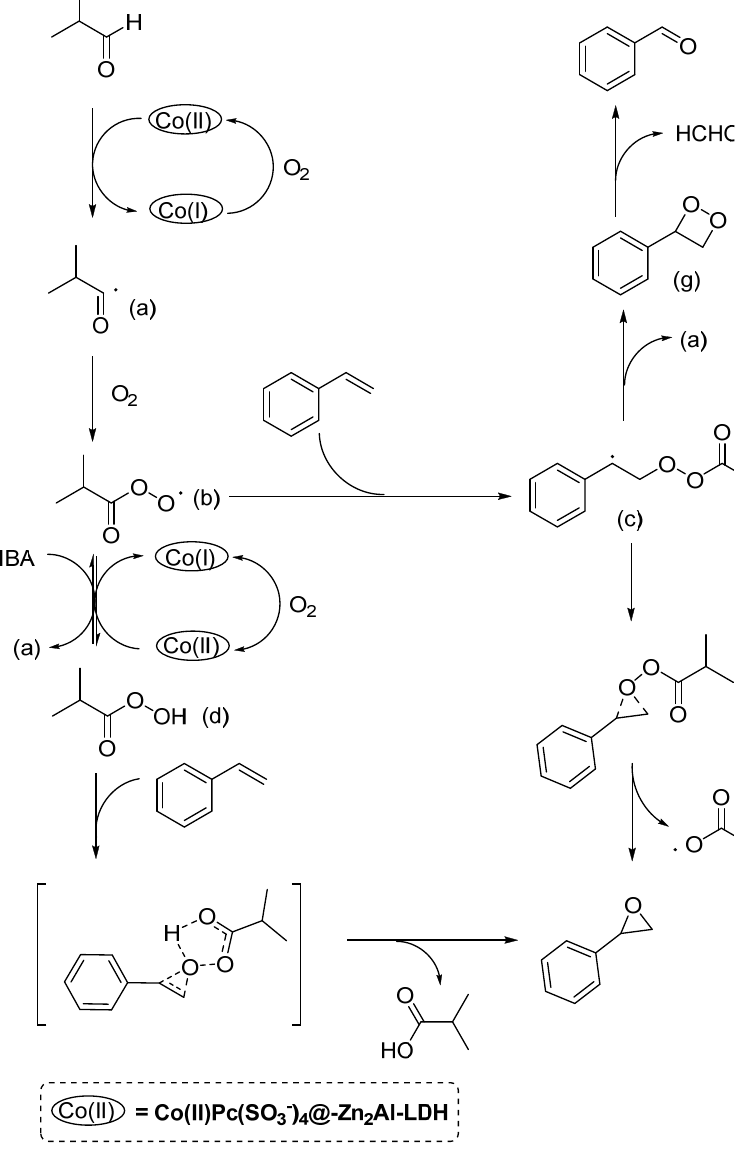
Figure 33. Proposed mechanism for the epoxidation of styrene over Co(II)Pc(SO 3 − ) 4 @-Zn 2 Al-LDH in the presence O 2 /IBA (adapted from [80]).